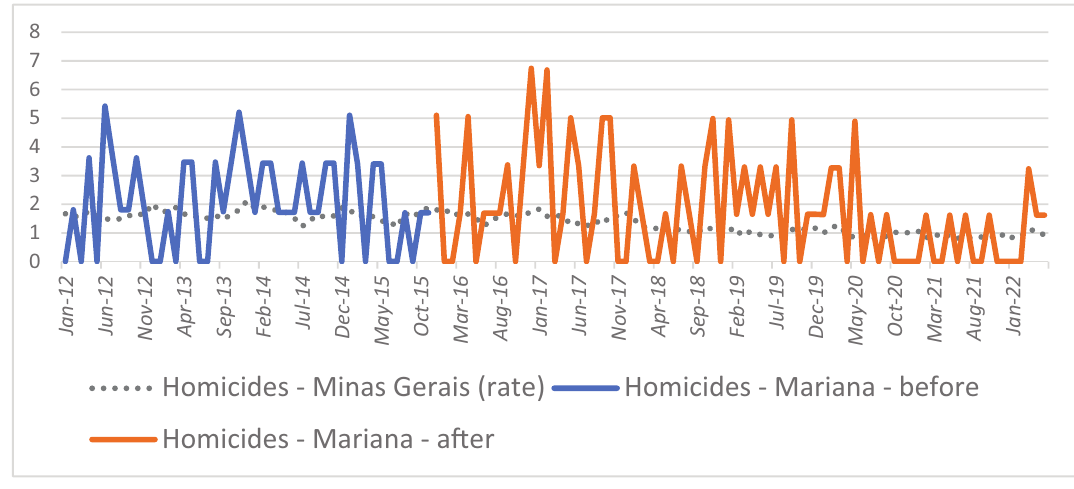
Figure 6. Rate of homicides per month, for Minas Gerais and Mariana – 2012- 2022 Source: Occurrences: Armazém Sisp (official data warehouse for Minas Gerais state public security system). Demographic data: